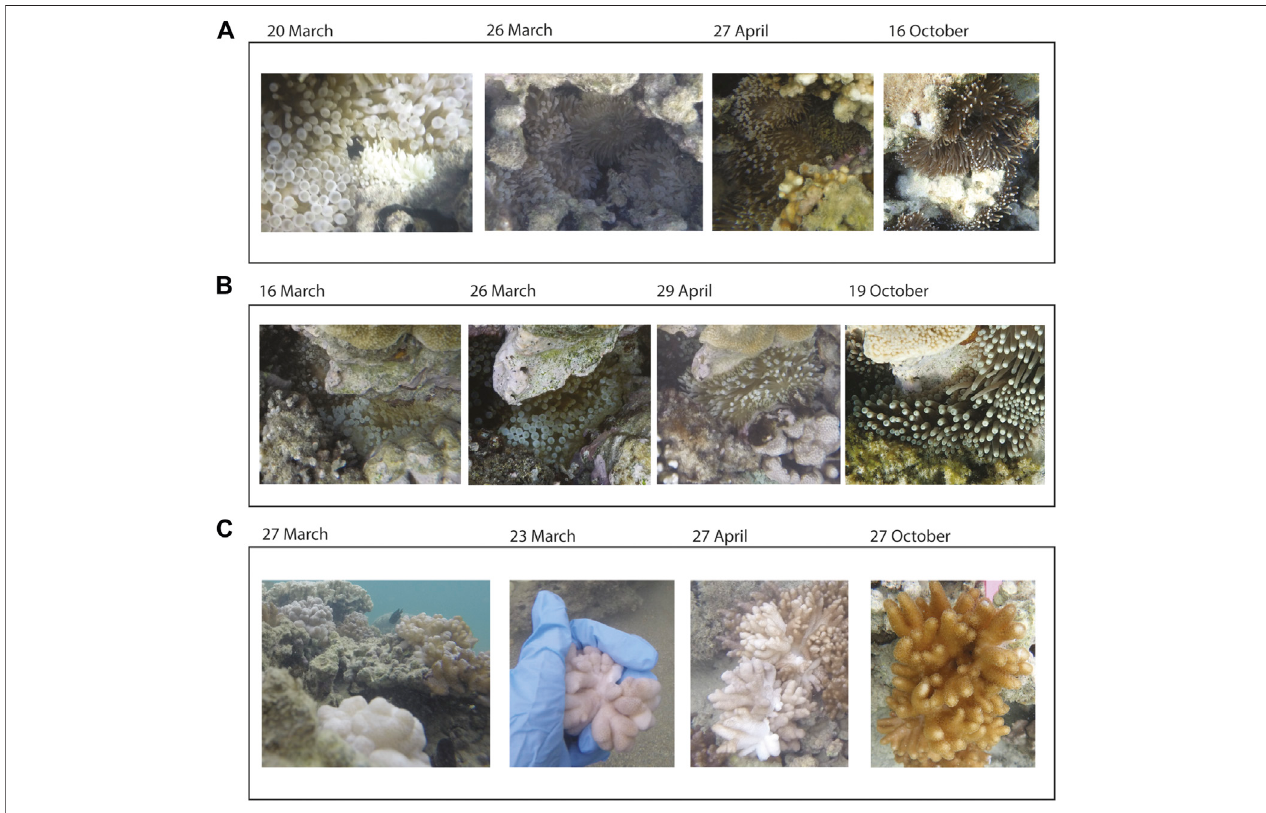
FIGURE 4 | Timelapse photos of Entacmaea quadricolor anemones and Cladiella sp. 1 octocorals. (A) Paled and bleached E. quadricolor anemones at Sylphs Hole, (B) a single bleached E. quadricolor anemone at North Bay, and (C) bleached, detached, and semi-detached Cladiella sp. 1 at Sylphs Hole. All photos by Rosemary K.